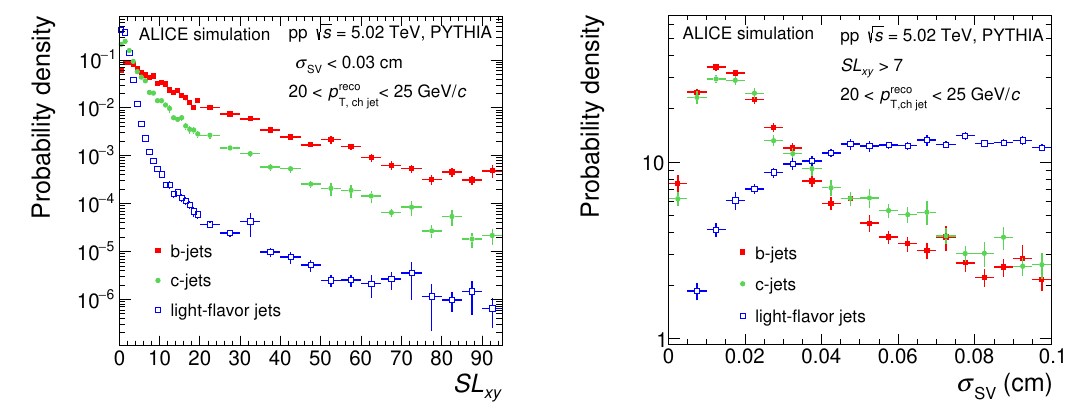
Figure 3. Distributions of the tagging discriminators used in the SV method, SL xy (left) and σ SV (right), for b jets, c jets, and light-flavor jets as obtained from a MC simulation of the ALICE apparatus, using PYTHIA as an event